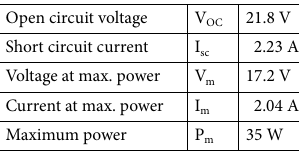
Table 1. Specifications of EBS solar module at standard conditions.